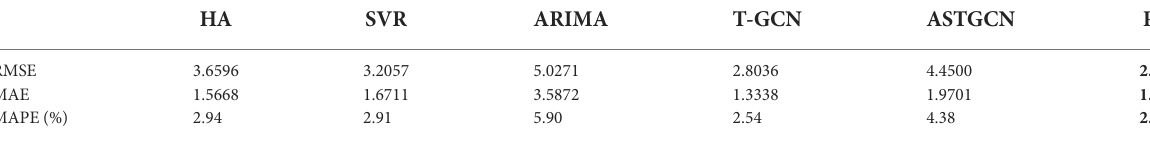
TABLE 3 PEMS08-30 min.